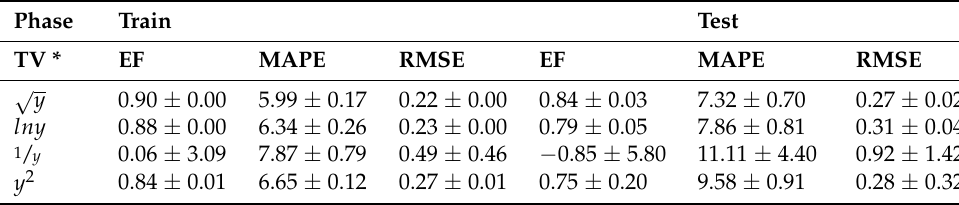
Table 5. MLR model performance parameters for four different transformation types.